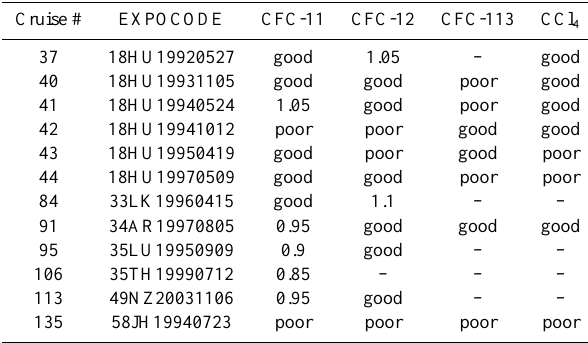
Table 2. List of cruises with adjustments for CFC data and as- signments of a “poor” quality flag. A “poor” quality flag has been assigned in the case of large data spread, which cannot be corrected by a simple adjustment factor.